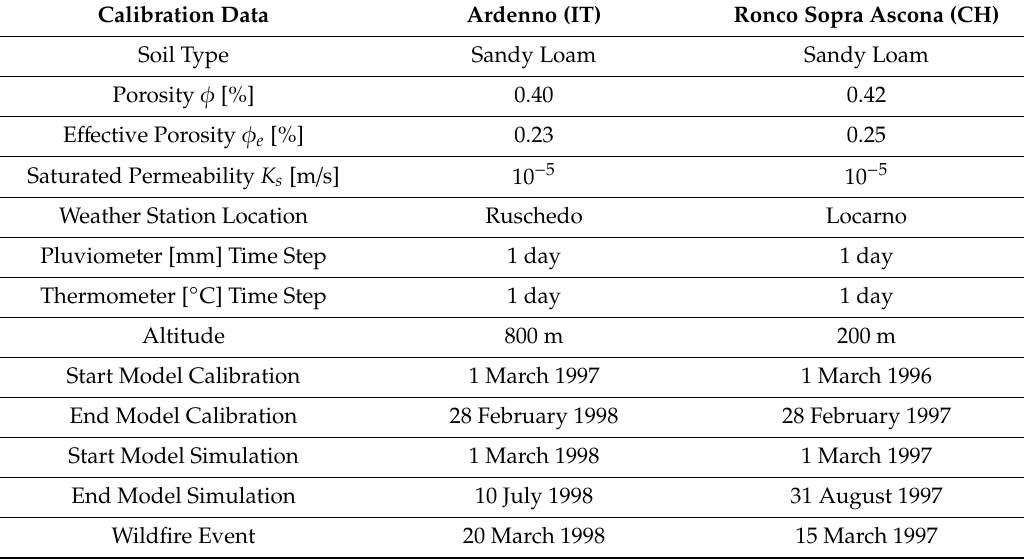
Table 1. Model Calibration and Simulation settings for Ardenno and Ronco sopra